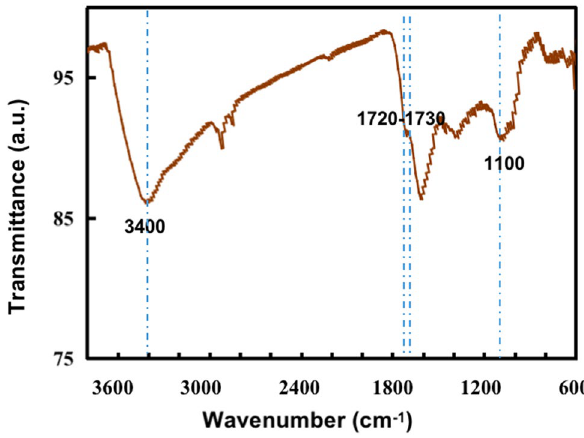
Figure 4. FT-IR spectra of the carbon ferrite sample.